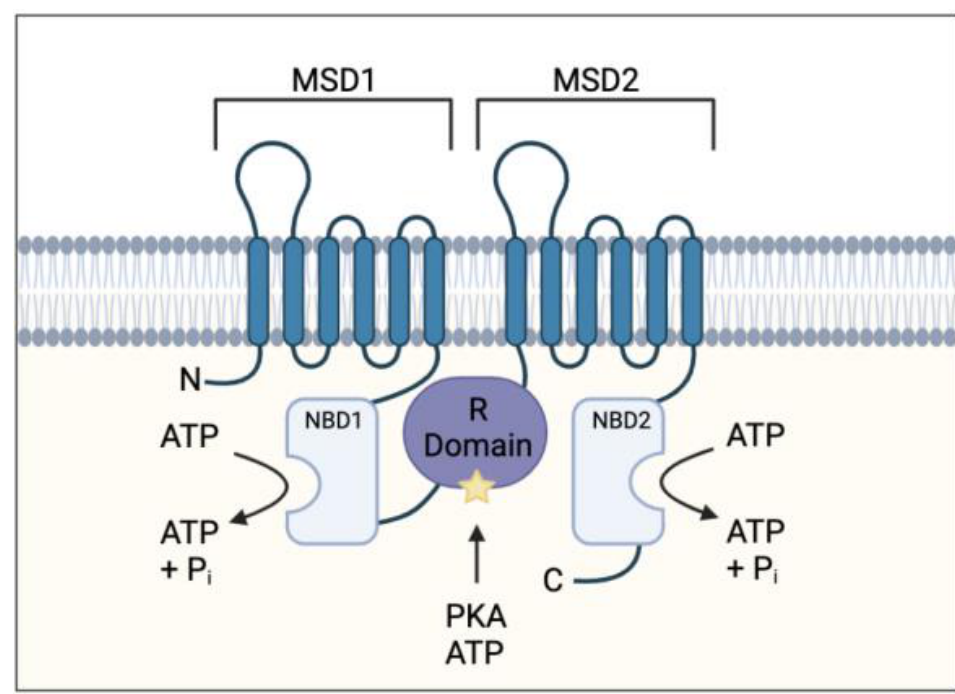
Figure 1. Cystic fibrosis transmembrane conductance regulator (CFTR) protein structure. Protein consists of two membrane-spanning domains (MSD), typically comprising of six transmembrane re- gions each which form the channel pore allowing chloride and bicarbonate transport; two nucleotide binding domains (NBD) which bind and hydrolyse ATP allowing for the channel to open; a single regulatory (R) domain, containing numerous charged amino acid and phosphorylation sites (star representing a phosphorylation site). The channel opens when R domain is phosphorylated, and NBDs are ATP-bound (adapted from Sheppard et al Physiol Rev. 1999 January 79 (1 Suppl): S23–S45). CFTR function influences the viscosity and pH of mucosal surfaces within several organs such as the lungs, pancreas, and intestines; hence, it is often associated with